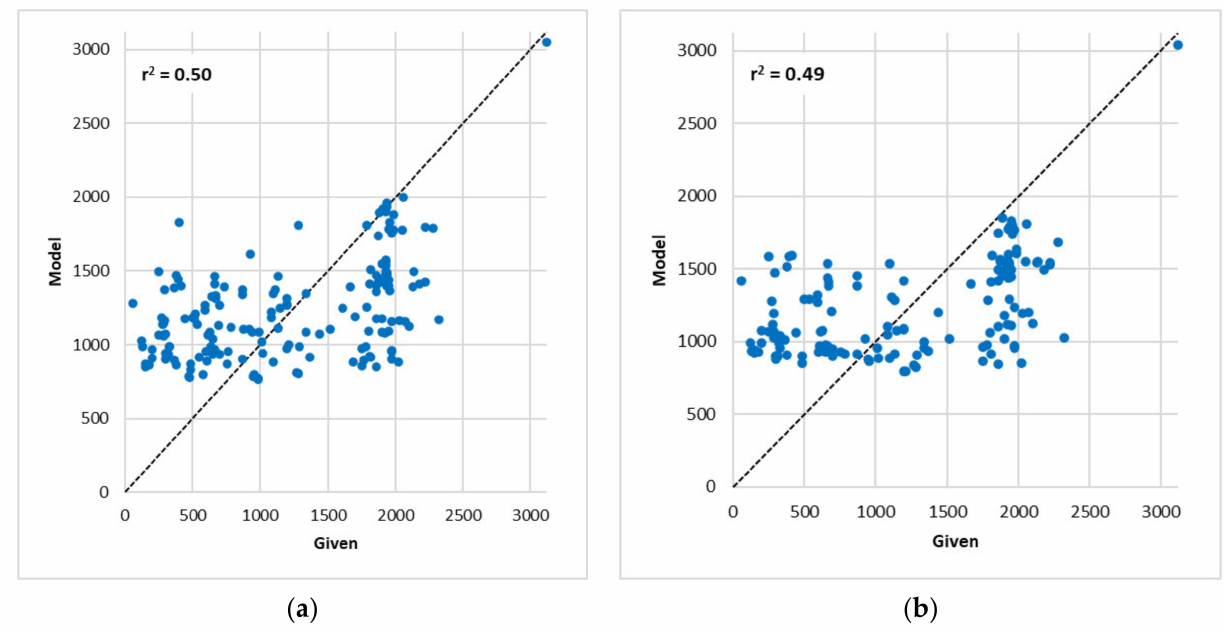
Figure 25. Plot of given and modelled sulfate content values based on Sentinel-2 ( a ) Level-1C TOA and ( b ) Level-2A BOA